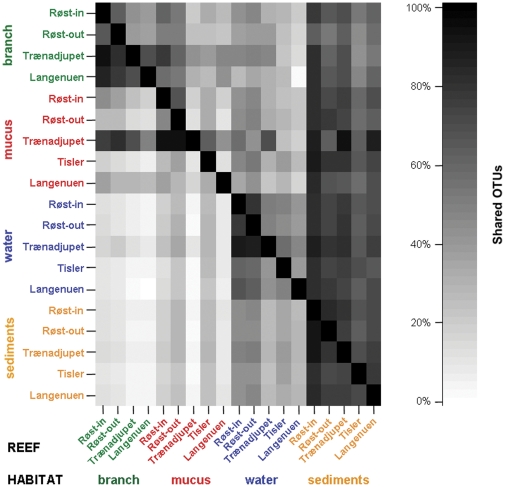
Pairwise comparison of OTU overlap between microbial habitats at each reef site.Samples were grouped according to microbial habitat type and reef site. In this asymmetrical representation, rows correspond to the reference group and columns to the group being compared. It provides an overview of potential directional dynamics between different microbial habitat types, with the respective fraction (%) of shared OTUs indicated by different degrees of shading.